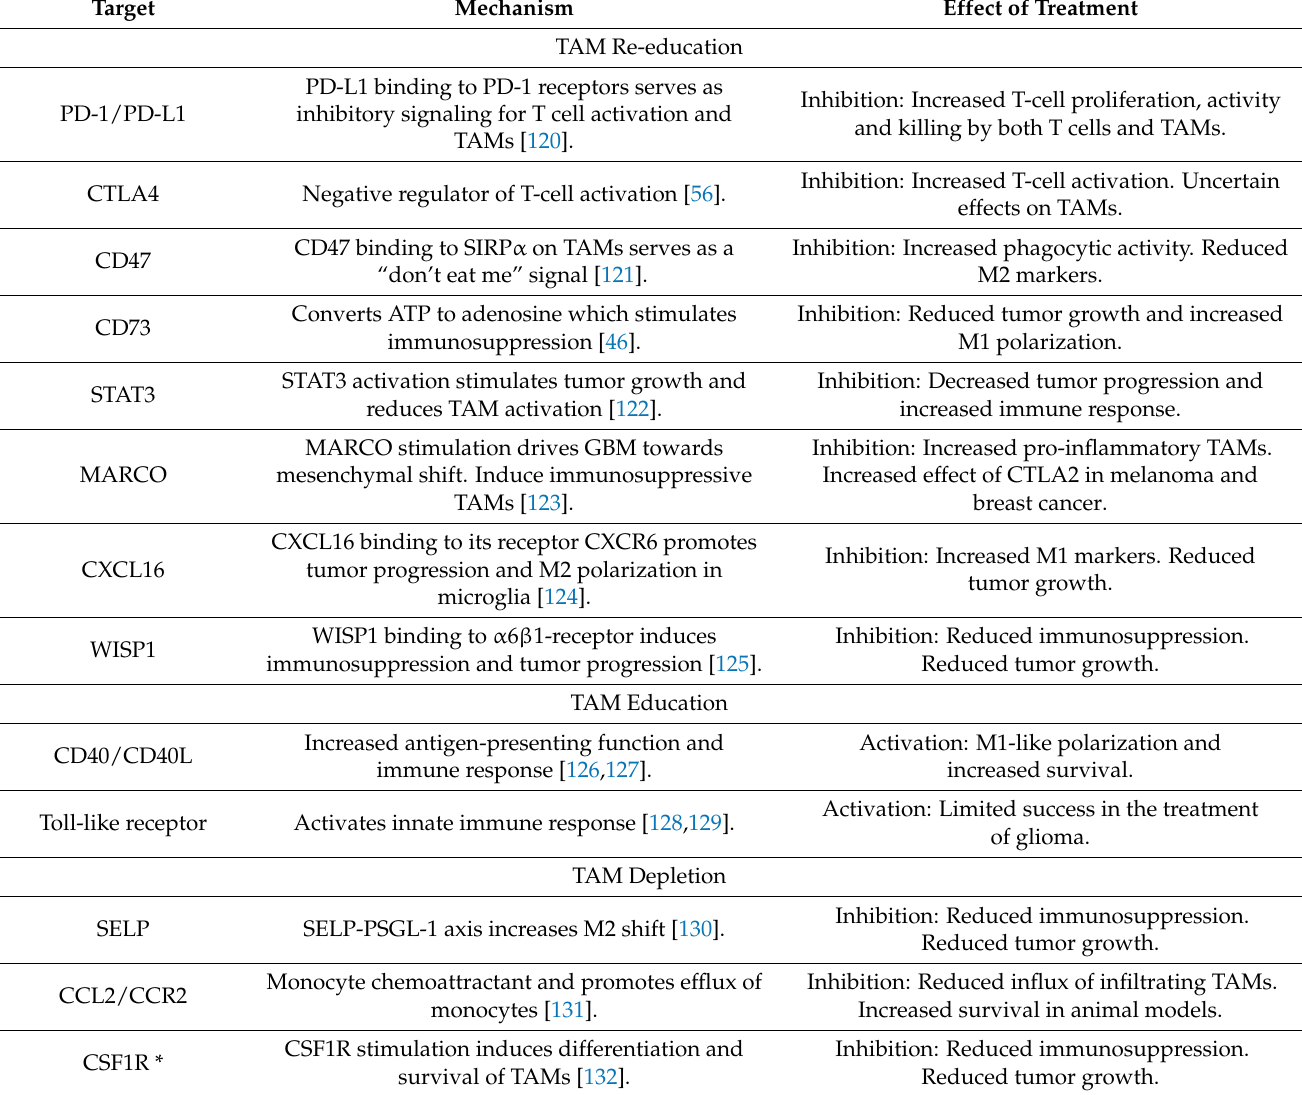
Table 1. Potential options for immunotherapy in